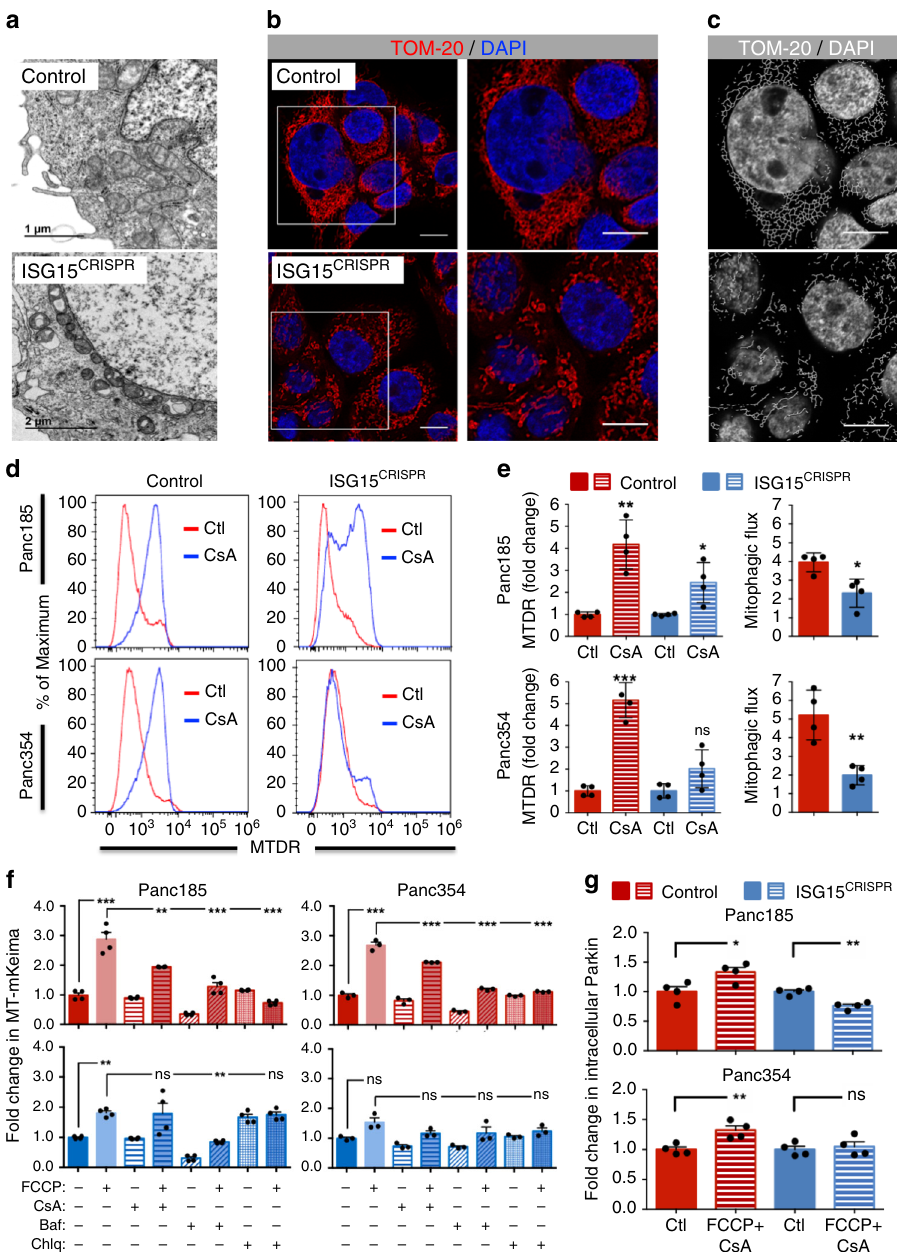
Fig. 5 Loss of ISG15/ISGylation reduces mitophagy. a Transmission electron micrographs of control and ISG15 CRISPR Panc354 cells. Scale bars = 1 or 2 µ M. b Immuno fl uorescent images of TOM-20 in control and ISG15 CRISPR Panc354 cells. Nuclei stained with DAPI in blue. Scale bars = 10 µ M. c Mitochondrial network from b displayed as a skeleton network using ImageJ skeleton fi lter. Scale bar = 10 µ M. d Representative histograms of MTDR expression in control and ISG15 CRISPR Panc185 and Panc354 cells after 6 h of treatment with CsA (5 µ M) or without (Ctl). e Mean fold change in MTDR levels ± sd in control (Ctl)- and CsA-treated cultures (left) and mitophagic fl ux determined as the ratio of MTDR accumulation after CsA treatment compared to its respective control (right) in control and ISG15 CRISPR Panc185 and Panc354 cells (Panc185: n = 4 biologically independent samples; ** p = 0.0013; * p = 0.0191; * p = 0.0111, as determined by Student ’ s t -test; and Panc354: n = 4 biologically independent samples; *** p < 0.001; ns, not signi fi cant; ** p = 0.0041, as determined by Student ’ s t -test). f Mean fold change in Keima protein fl uorescence levels ± sem in control (red) and ISG15 CRISPR (blue) Panc185 and Panc354 cells. Cells were untreated or treated with FCCP (16 µ M), with or without co-treatment with the autophagy inhibitors CsA (5 µ M), Ba fi lomycin (Baf; 150 nM) or Chloroquine (Chlq; 50 µ M). Fluorescence in control-treated cells is set to 1.0. ( n = 4 biologically independent samples for Panc185 and n = 3 biologically independent samples for Panc354; ** p < 0.01; *** p < 0.001, ns, not signi fi cant, as determined by one-way ANOVA with Dunnett ’ s multiple comparison test). g Summary of average fold change in parkin levels ± sem, determined by fl ow cytometric analysis, in control and ISG15 CRISPR Panc185 and Panc354 cells untreated (Ctl) or treated with FCCP (16 µ M) plus CsA (5 µ M) for 4 h (Panc185: n = 4 biologically independent samples; * p = 0.0283; ** p = 0.0013, as determined by Student ’ s t -test; and Panc354: n = 4 biologically independent samples ** p = 0.0084; ns, not signi fi cant, as determined by Student ’ s t